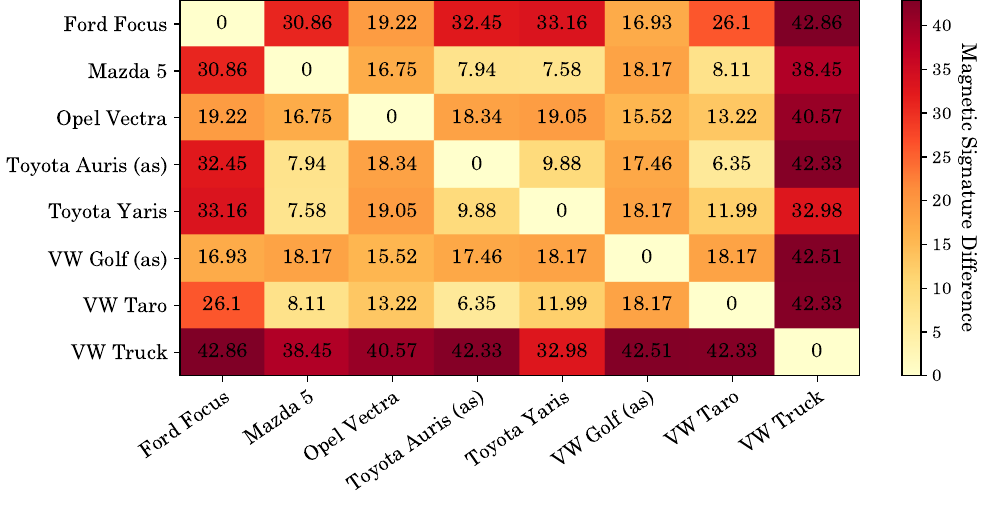
Figure 12. Difference in magnetic field signature (Z-axis) among